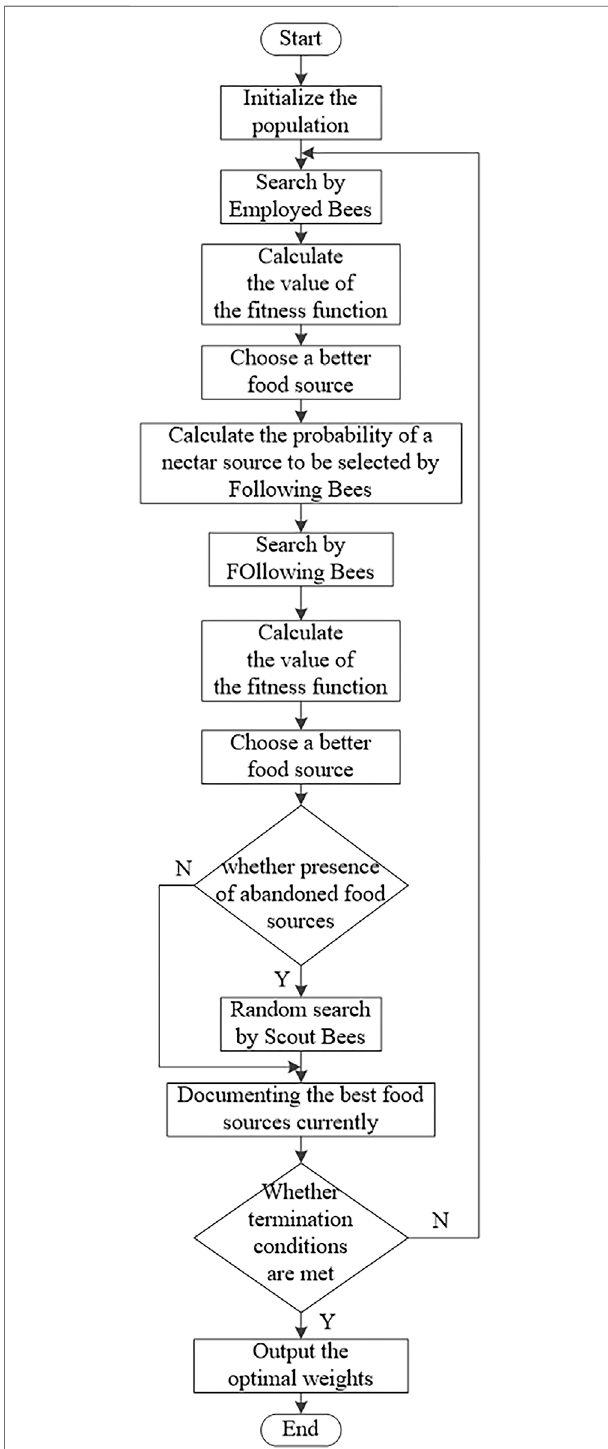
FIGURE 8 | Flowchart of arti fi cial bee colony